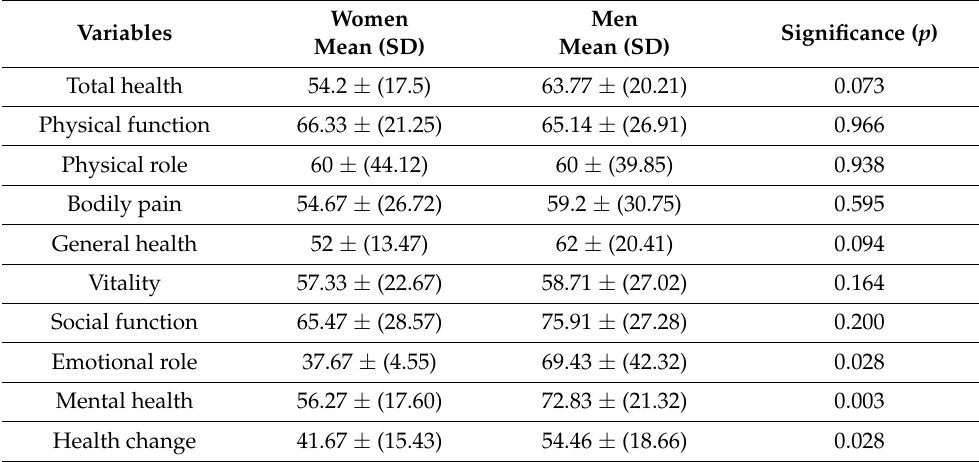
Table 3. SF-36 questionnaire for HRQL dimension descriptive analysis and